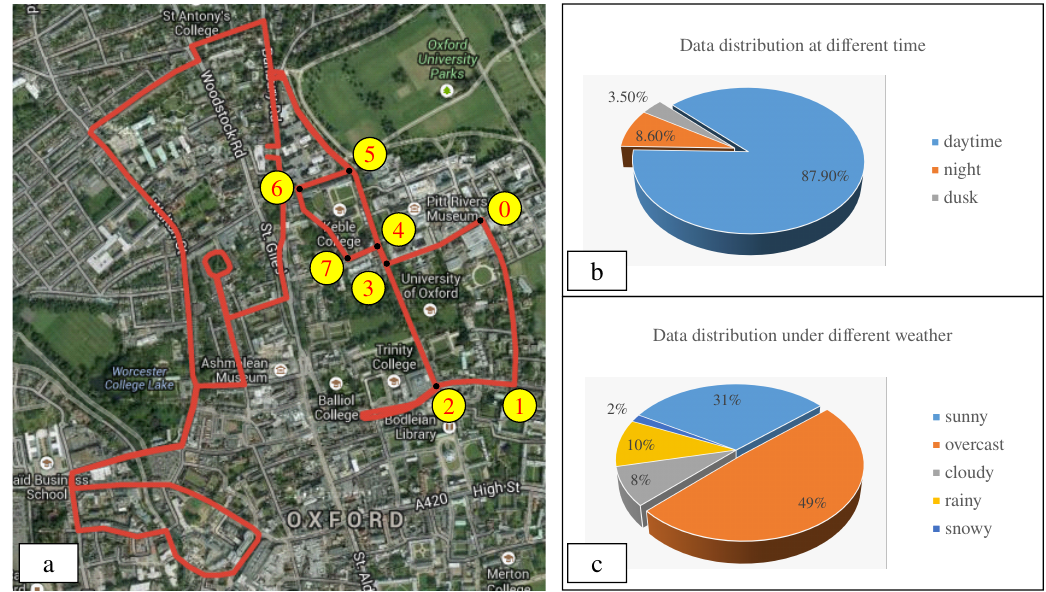
Figure 5. Dataset information. ( a ) the selected intersections (marked with yellow number) on the map [6]. ( b ) data distribution at different time. ( c ) Data distribution under different